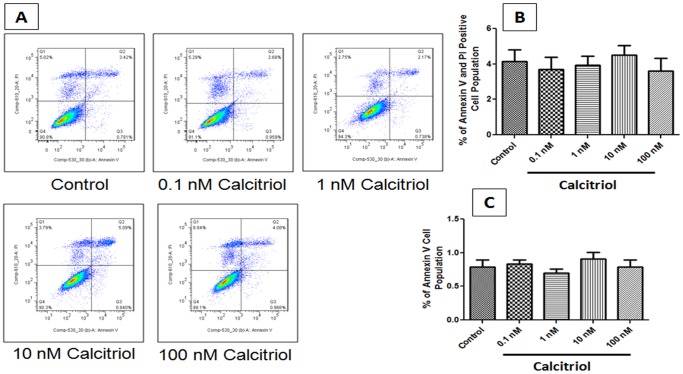
Effect of calcitriol on cell apoptosis in PCASMCs.Synchronized PCASMCs were stimulated with calcitriol stimulation (0.1–100 nM) for 24 h. (A) Dual parameter flow cytogram of FITC-labeled annexin V (Abscissa) vs PI staining (ordinate). Early apoptotic cells were labeled with annexin V only (Quadrant 3) while late apoptotic cells were positive for both annexin V and PI (Quadrant 2). Viable cells were negative both for annexin V and PI (Quadrant4); Necrotic cells were positive for PI only (quadrant 1). (B–C) Representative data of apoptosis of PCASMCs. Data shown are Mean ± SEM (N = 3).